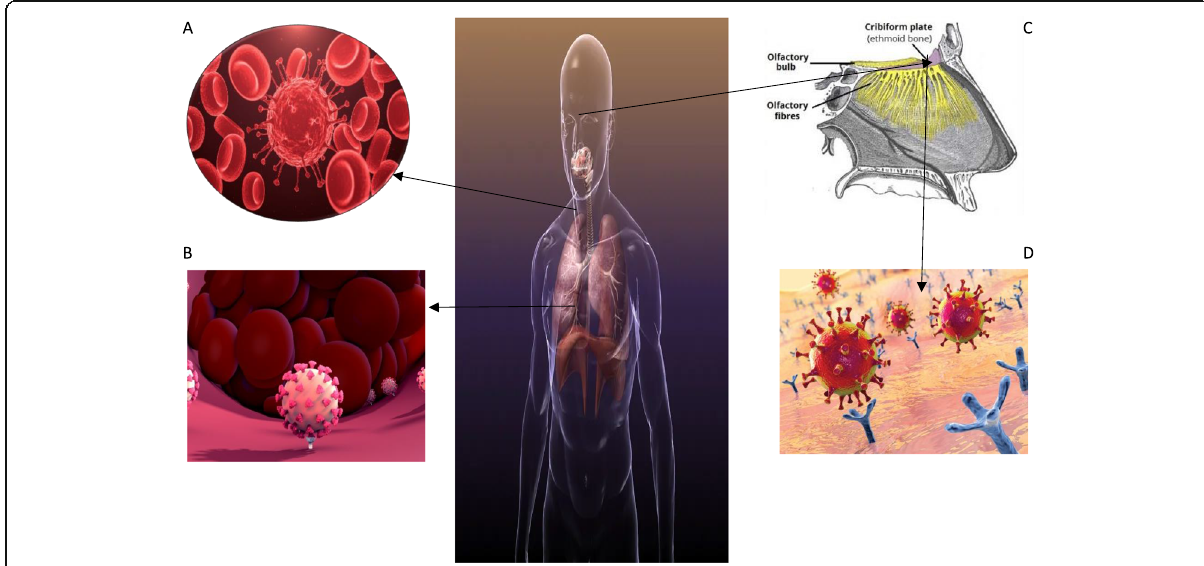
Fig. 1 The mechanism of COVID-19 attacking the nervous system through ACE2 distribution [34]. ( a ) COVID-19 virus enter the brain circulation. ( b ) The virus particles will damage the endothelial lining thus supporting the virus to go through the brain. ( c ) COVID-19 virus will spread to the circulation or via the cribriform plate of the ethmoid bone. ( d ) The virus then will interact with the ACE2